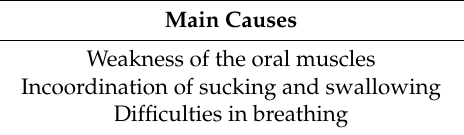
Table 4. Causes of dysphagia in patients with neuromuscular diseases